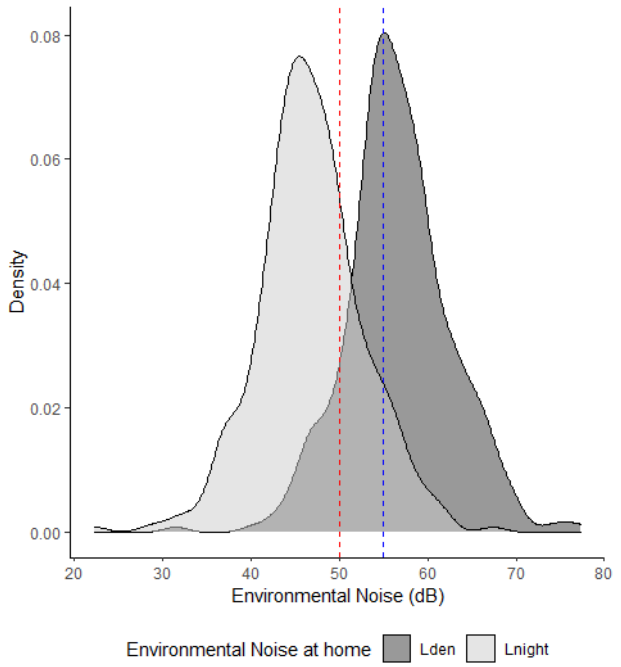
Figure 2. Environmental noise exposure density plot in the total sample: L den and L night at home. The dotted lines show high environmental noises defined by the 7th EAP as high noise levels. Table 2. Exposure means for each socioeconomic group. The results presented in the table are based on the total sample. For each group, sample size (N), frequencies and environmental noise means are given.